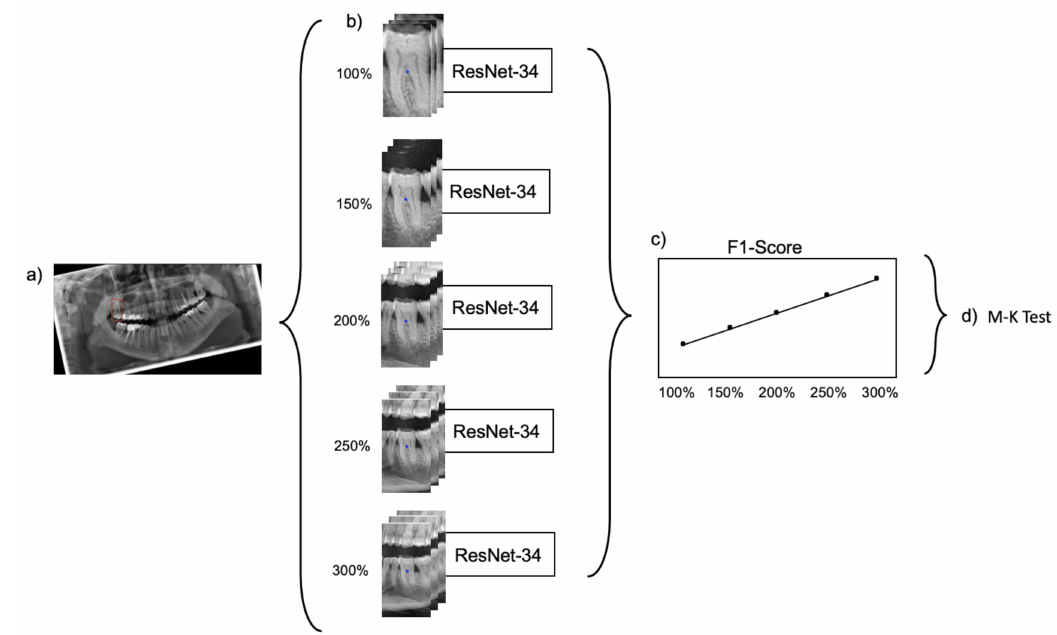
Figure 2. Visualization of workflow. ( a ) Panoramic radiograph with an annotated bounding box around one tooth. ( b ) Extraction of image segments with varying image context information. Training of one ResNet-34 model for each crop size. ( c ) Collection of the F1-scores based on the performance on the unseen test set. ( d ) Application of the Mann– Kenndall